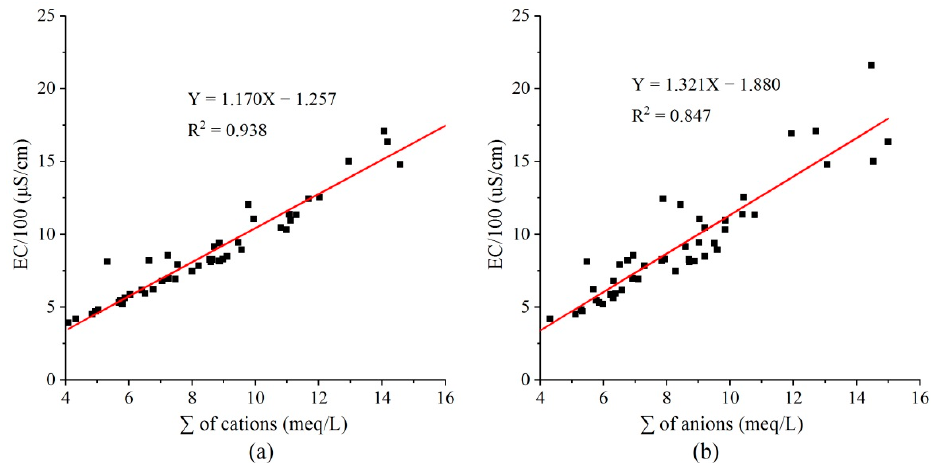
Figure 2. Ionic balance of groundwater data: ( a ) Σ of cations vs. EC/100; ( b ) Σ of anions vs. EC/100.